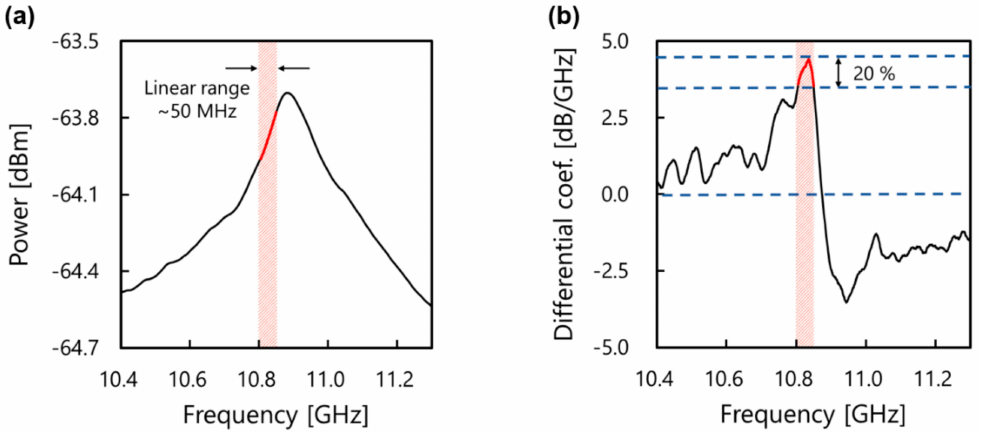
Figure 6. ( a ) Measured BGS and ( b ) its differential coefficient at each frequency. The linear region of the lower-frequency side is indicated. Reproduced with permission from [59]. Copyright (2016) IEEE.